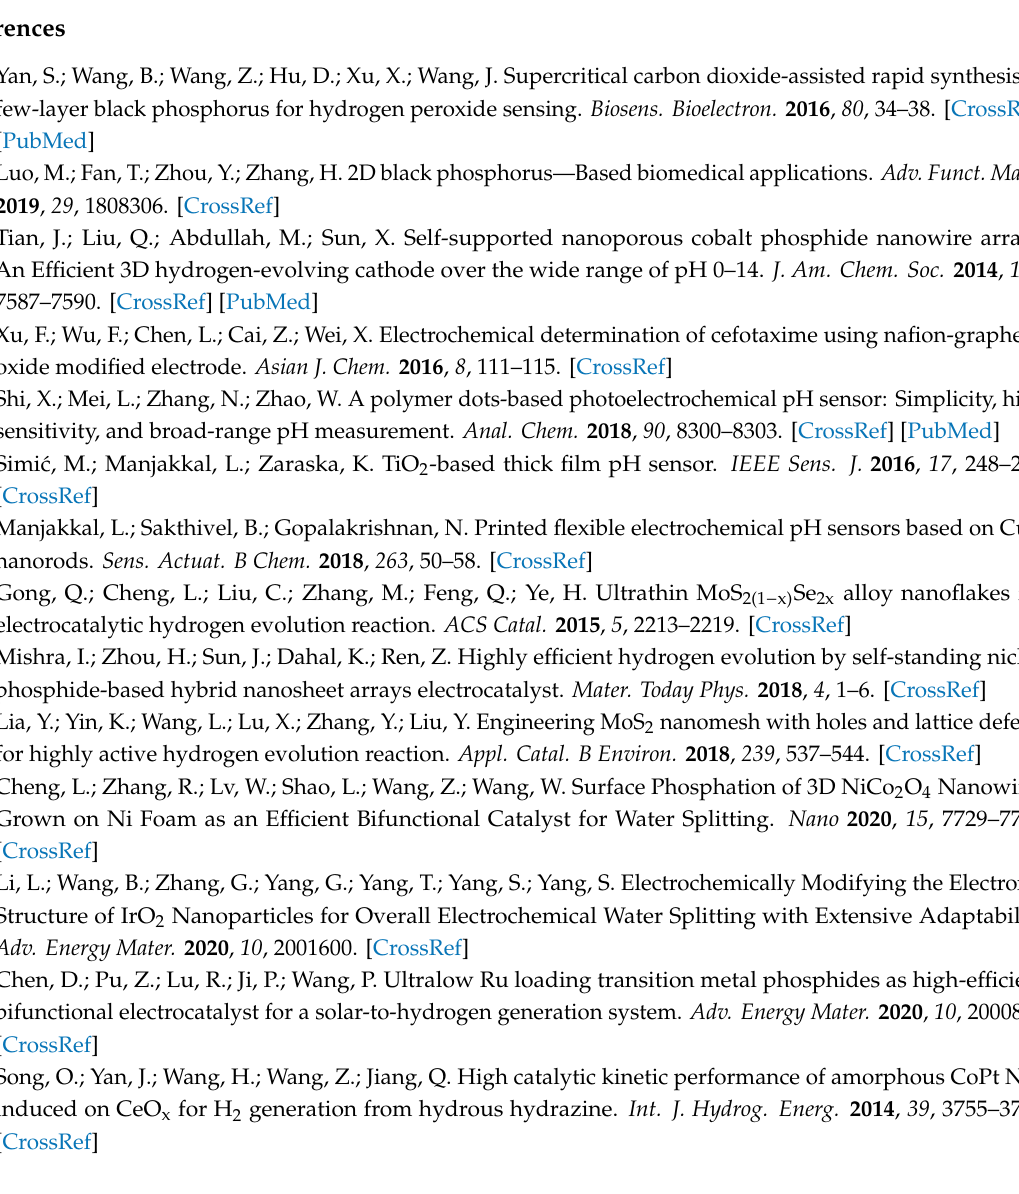
Figure A2. ( a ) LSV polarization curve of Co-FeS 2 / CoS 2 nanowires in KOH solutions of di ff erent pH; ( b ) Scatter plot corresponding to overpotential at current density 10 mV cm − 2 in Figure A2a.